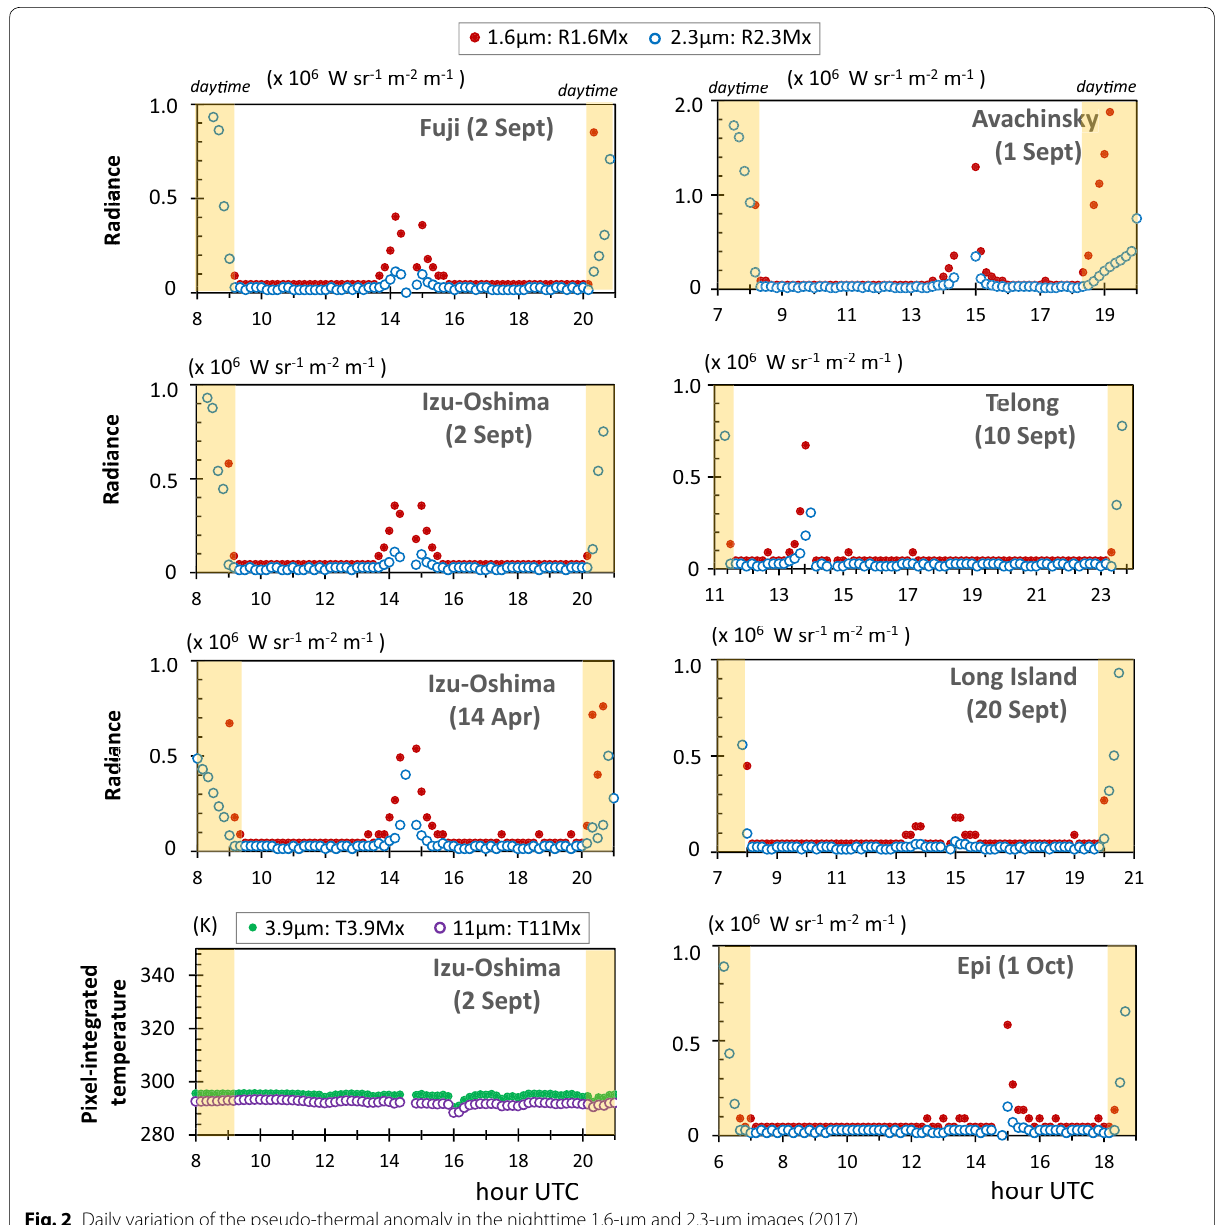
Fig. 2 Daily variation of the pseudo-thermal anomaly in the nighttime 1.6-µm and 2.3-µm images